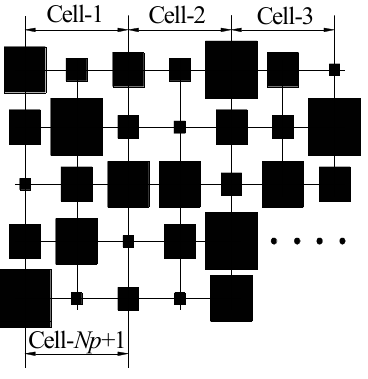
Figure 2. Schematic diagram of the generation of multi-cell fractal porous material.